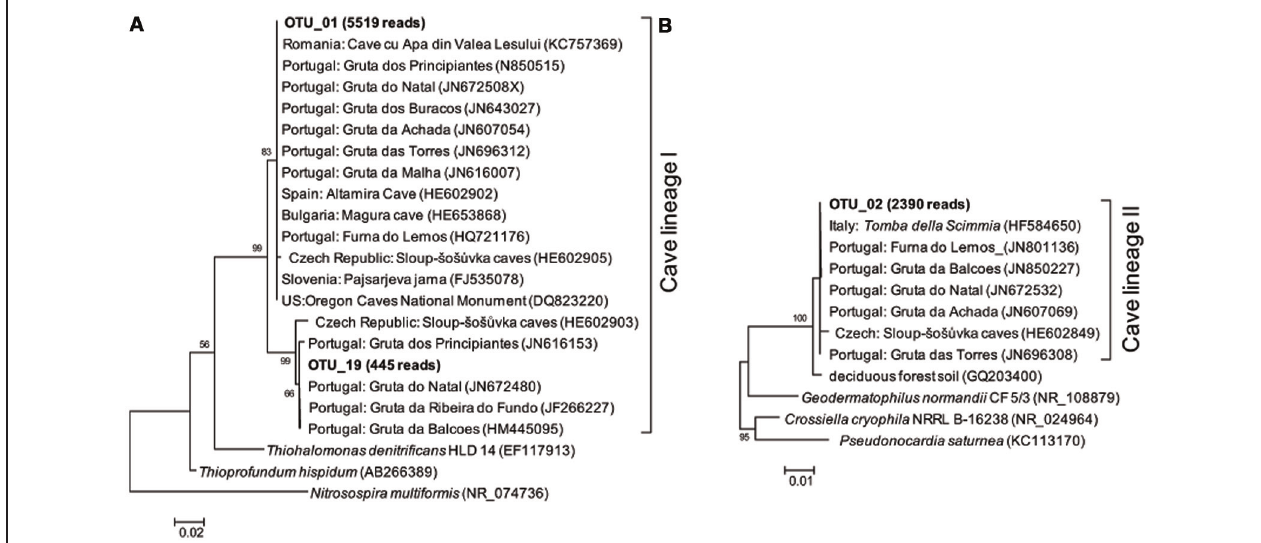
FIGURE 4 | Maximum likelihood (M-L) tree of two cave bacterial lineages, respectively, dominant in cave wall deposits A/B (A) and E/F (B). Sequences retrieved from the present study are shown in bold, with the number in parentheses indicating the total reads. Bootstrap values > 50% are shown in the